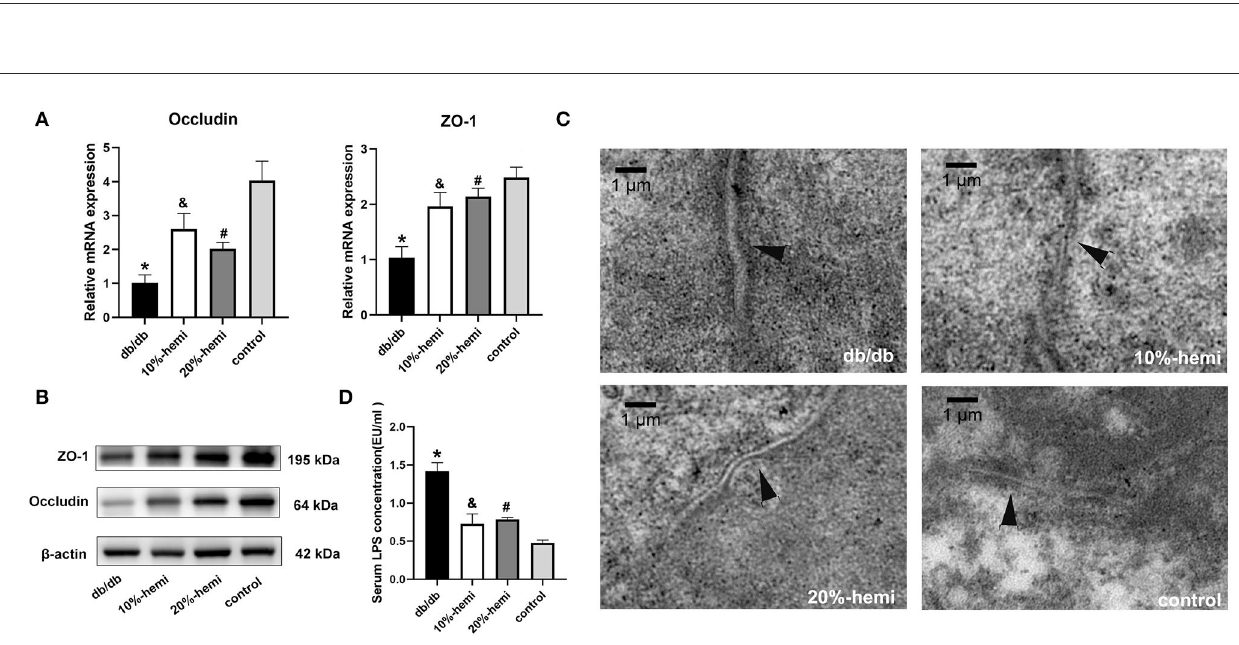
FIGURE2 TJ protein expression, intercellular gap of the colonic epithelium, and serum LPS levels for the four groups. (A , B) mRNA and protein expressions of occludin and ZO-1 of the colonic epithelium for the four groups (* db/db Vs. control, p < 0.01; &10%-hemi Vs. db/db, p < 0.01; # 20%-hemi Vs. db/db, p < 0.01). (C) intercellular gap of the colonic epithelium for the four groups showed by TEM (scale bar = 1 µ m). (D) serum LPS levels for the four groups. (*db/db Vs. control, p < 0.01; &10%-hemi Vs. db/db, p < 0.01; # 20%-hemi Vs. db/db, p <